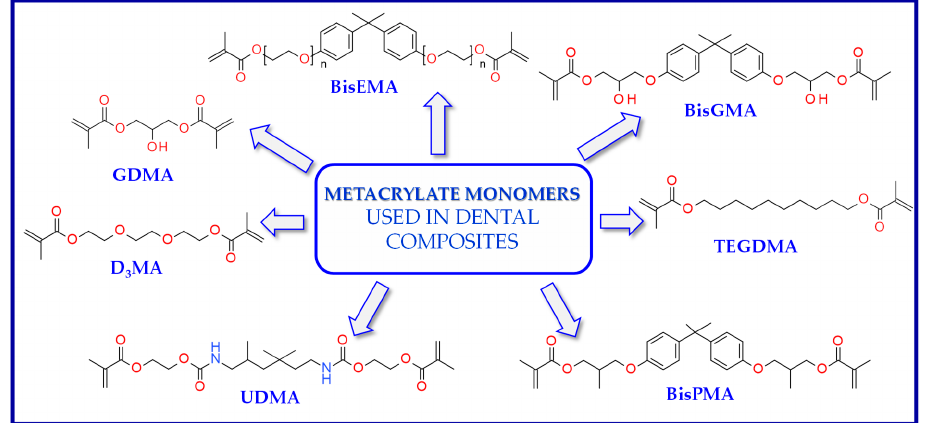
Figure 3. Examples of methacrylate monomers used in commercial and conventional dental composites based on free radical photopolymerization mechanism.